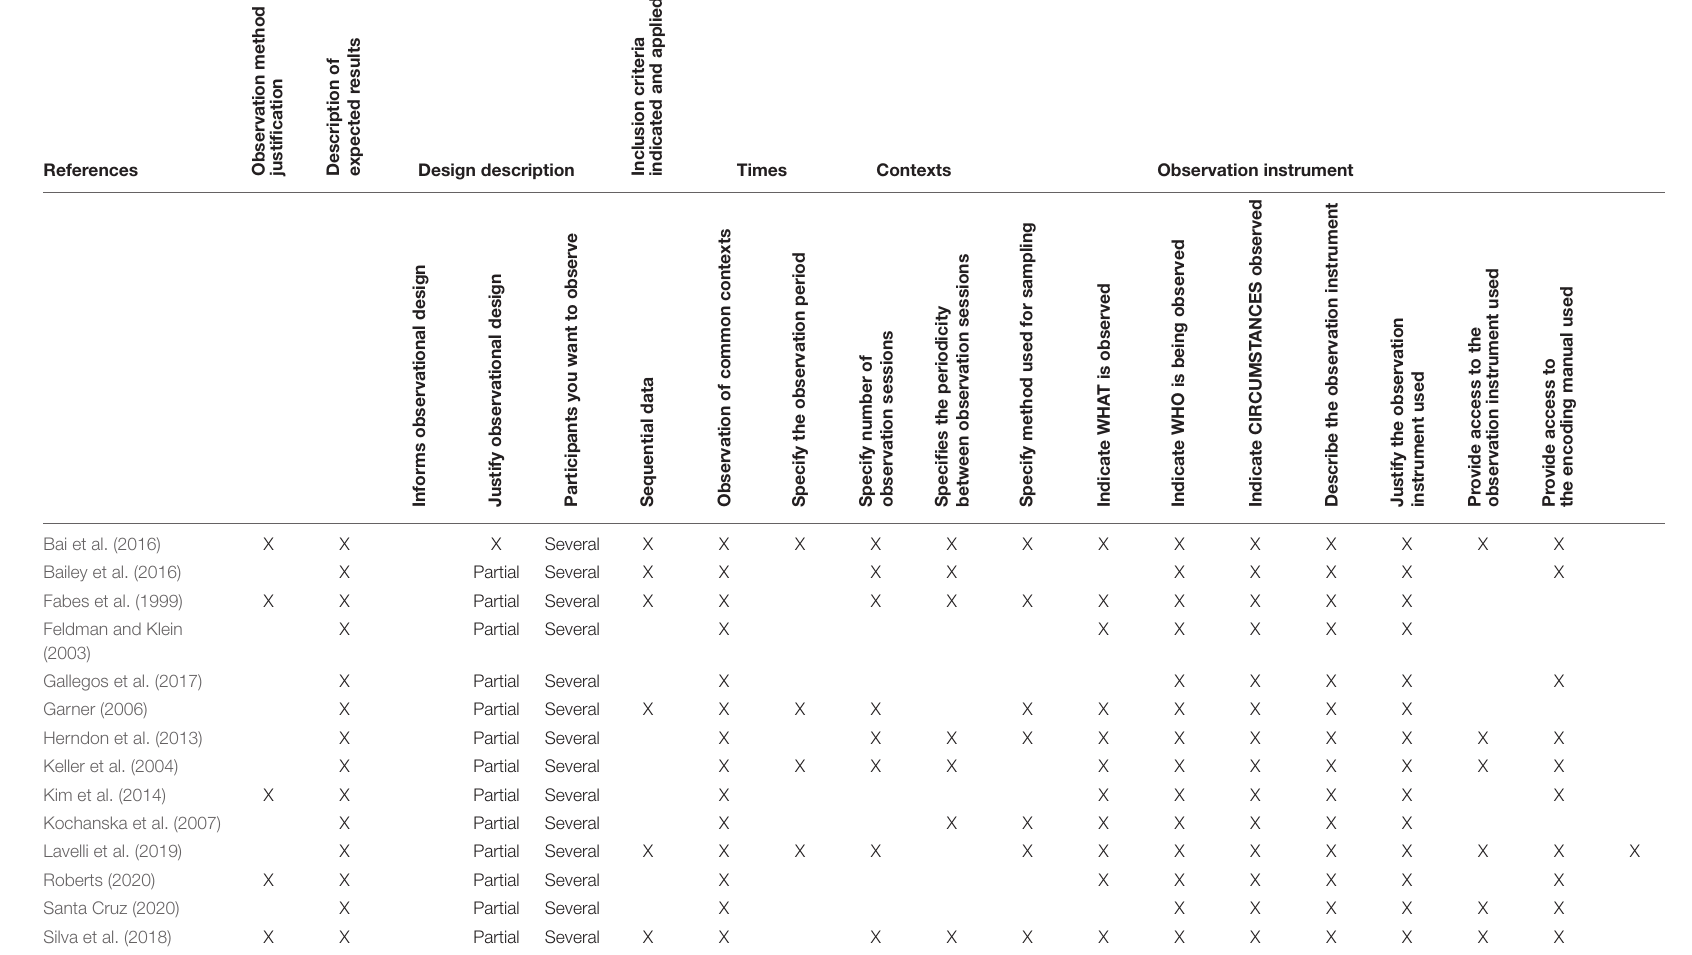
TABLE 5 | Methodological characteristics observed through the Guidelines for Reporting Evaluations based on Observational Methodology -GREOM- (first